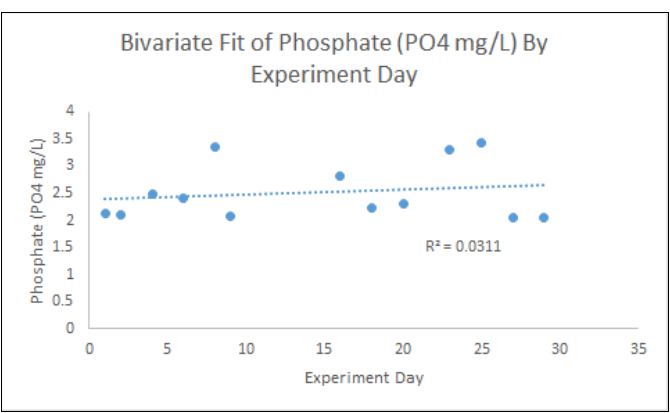
Figure 6. The correlation of phosphate to time shown in days.